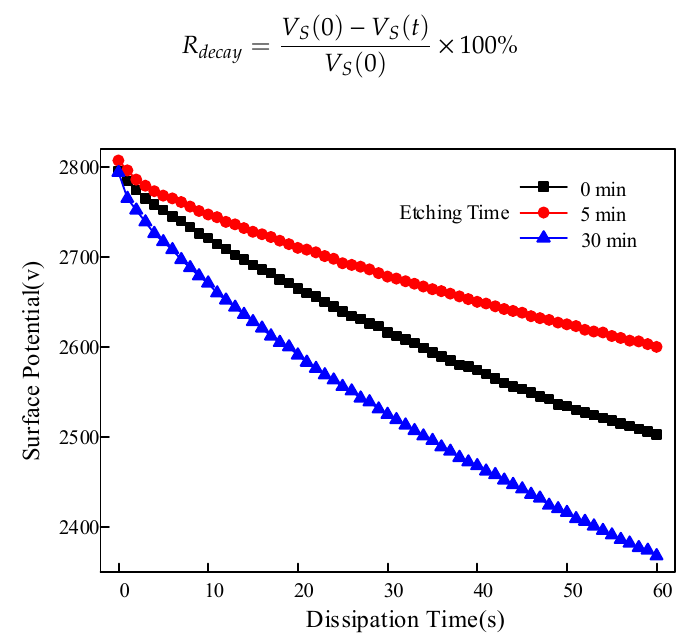
Figure 4. Surface potential decay curve of samples with different etching times.